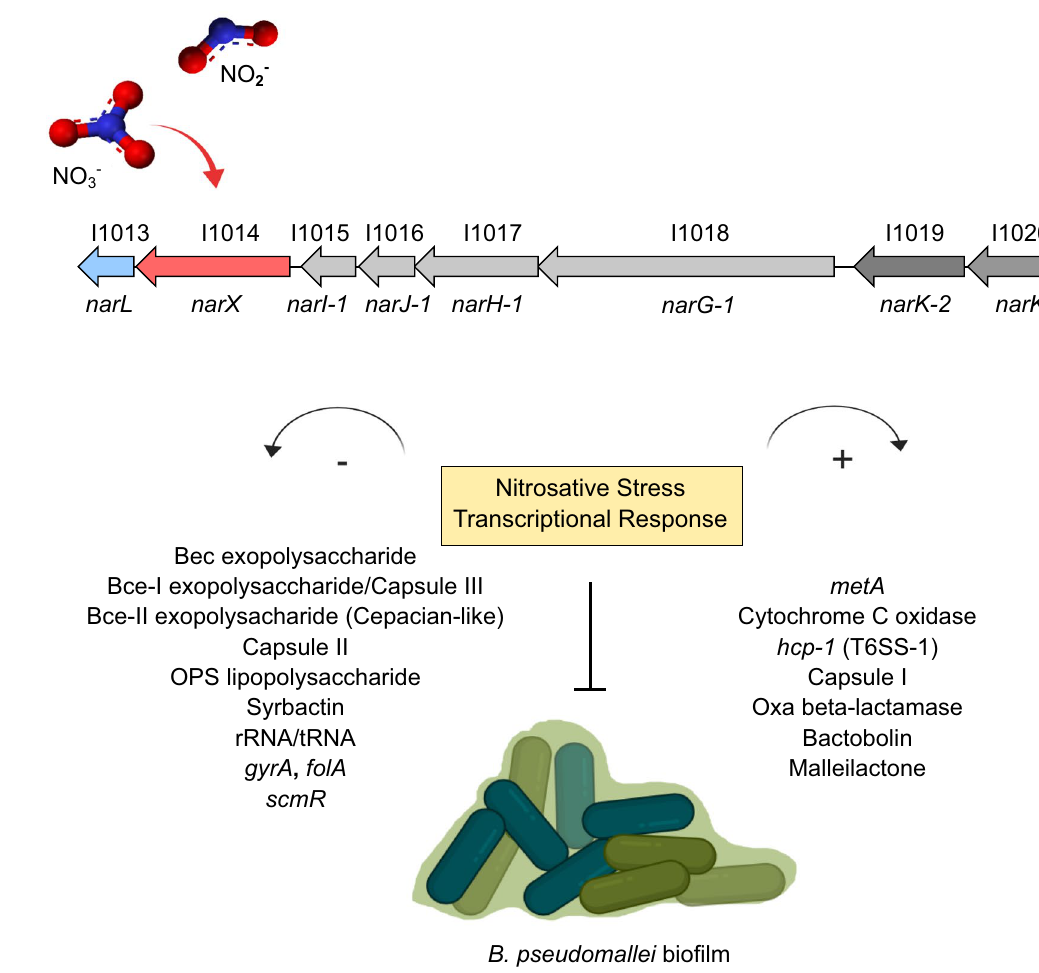
Figure 6. Model of nitrate-dependent biofilm inhibition and transcriptional response in B. pseudomallei 1026b. Nitrate, and to a lesser extent nitrite, activate the narXL sensing mechanism in B. pseudomallei which leads